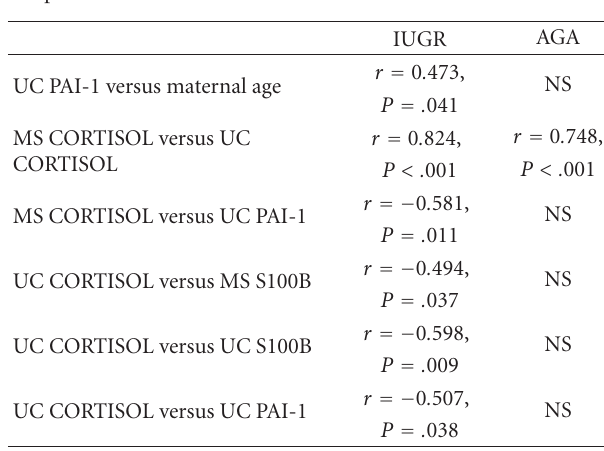
Table 2: Significant correlations among hs-CRP, PAI-1, S100B and cortisol levels in IUGR and AGA groups of the MS, UC, N1, and N4 samples.